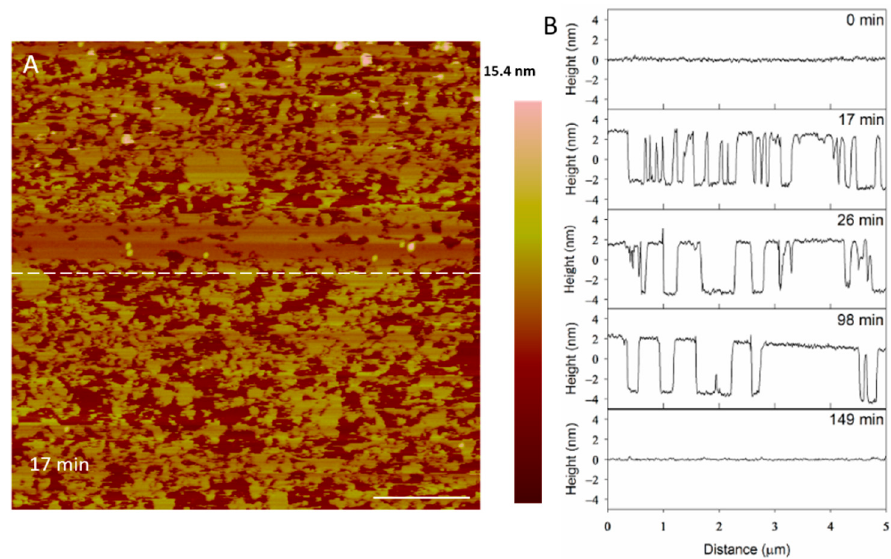
Figure 9 . Evolution of PC membrane defects over time after exposure to 5 µM indolicidin. The dashed line ( A ) shows the location of the height profiles ( B ) on the substrate. The scale bar represents 1 µm.